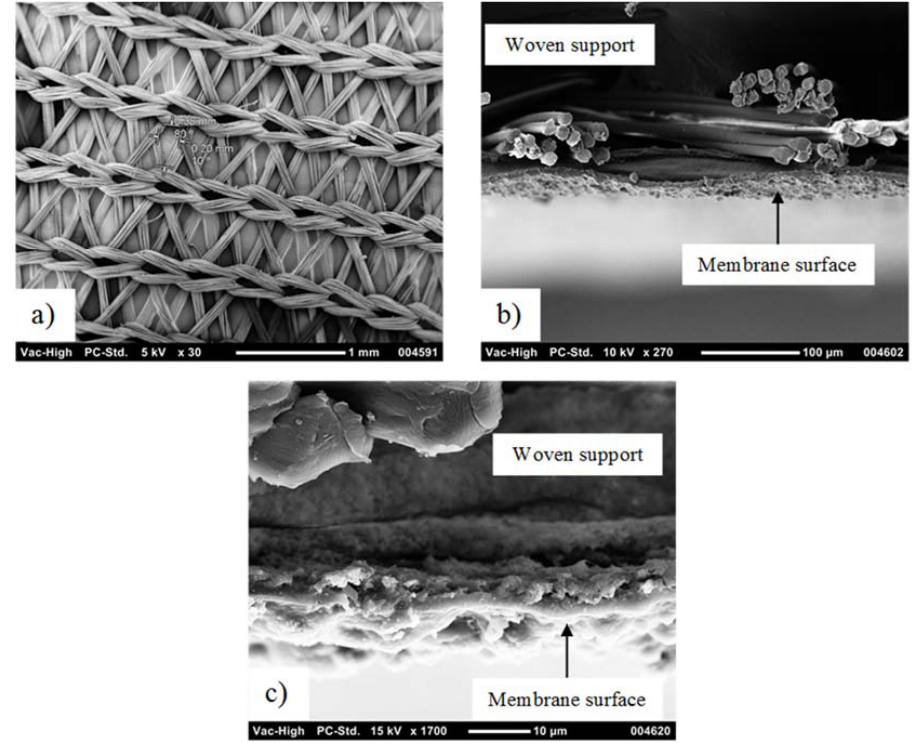
Figure 3. Hydrophilic-coated hydrophobic PTFE membrane: ( a ) woven support (backing); ( b ) side view; and ( c ) side view (zoomed